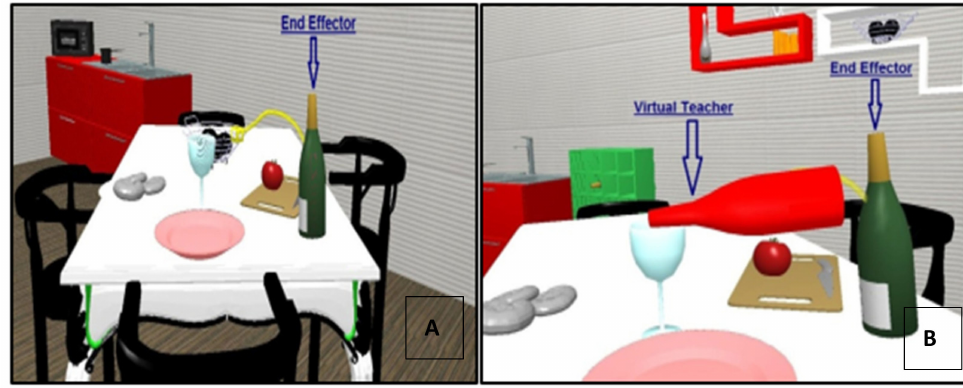
Figure 3. Virtual scenarios of the Virtual Reality Rehabilitation System (VRRS ® ). ( A ) On the left, the scenario presented to the No-Teacher group: the green bottle is the end-effector which is controlled by patient’s hand wearing the sensorized glove. The task to accomplish is represented by the exact trajectory to accomplish, but no virtual teacher can be emulated to perform the task accurately. ( B ) On the right, the scenario presented to the Teacher group: the red bottle represents the virtual teacher, performing the exact trajectory displayed by the Virtual Reality Rehabilitation System (VRRS). In real-time the patient can emulate with the green bottle (controlled by own movements) the exact movement of the virtual teacher (red